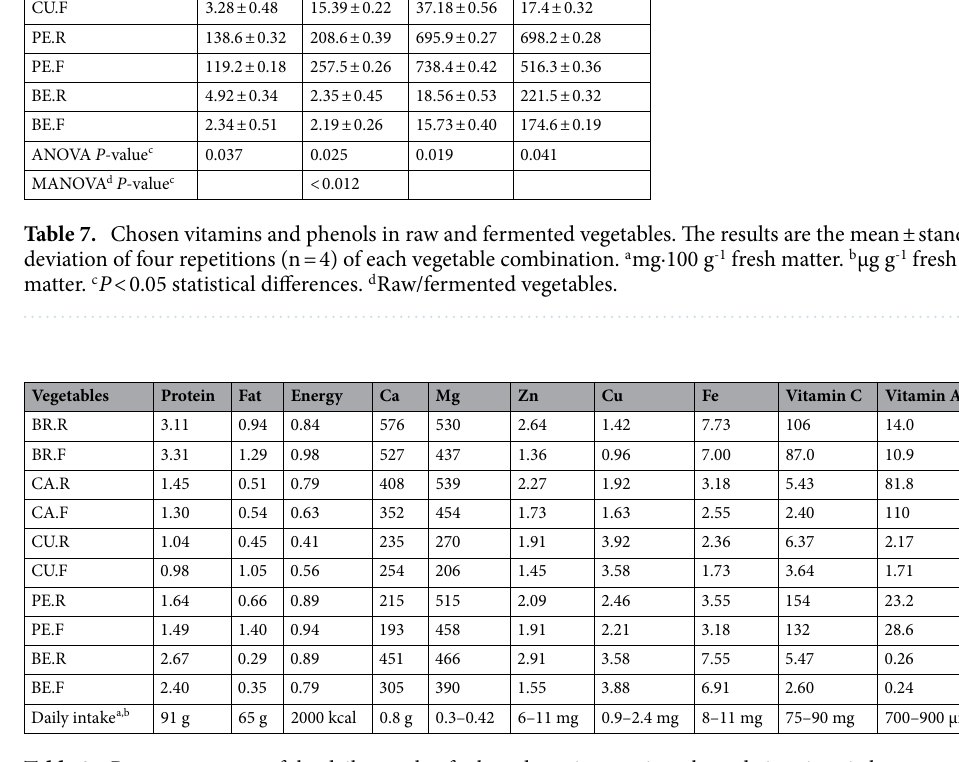
Table 8. Percent coverage of the daily supply of selected nutrients, minerals, and vitamins via human consumption of one serving of raw and fermented vegetables. One serving: 100 g accepted as an average portion 17 . a Dietary Guidelines for Americans 17 . b Food Standards for the Polish Population 18 .